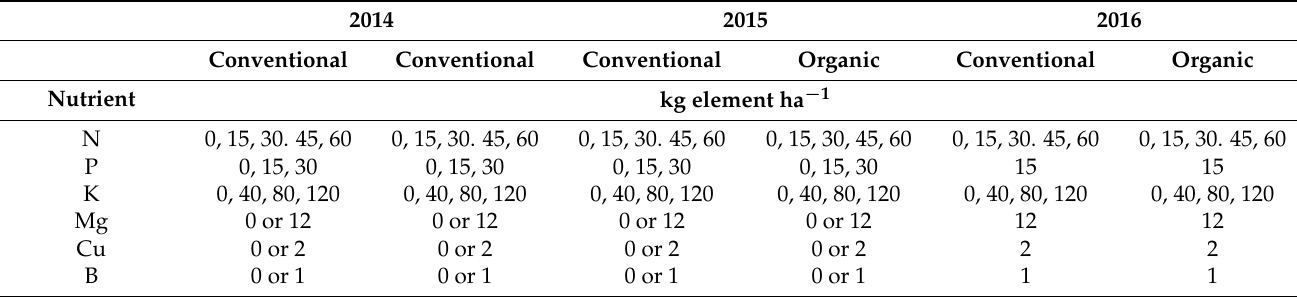
Table 2. Fertilization treatments during the 2014–2016 period at conventional and organic